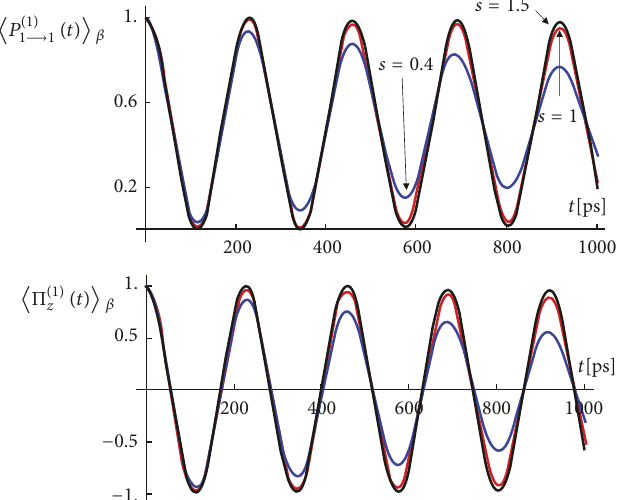
Figure 4: The thermal averages of the survival probability (upper panel) and the spin polarization (lower panel) assuming that the density of levels 𝜌 𝜐 (𝜀) is ∝ 𝜀 𝑠 . The plots shown here are for the subohmic 𝑠 = 0.2 , ohmic 𝑠 = 1 and superohmic 𝑠 = 1.5 dissipation forms and for 𝑇 = 300